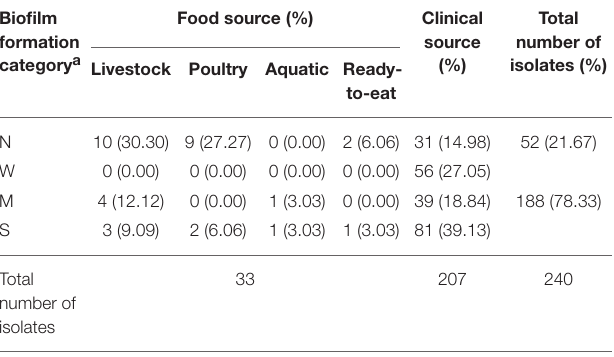
TABLE 4 | Biofilm formation of the total 240 S. Typhimurium